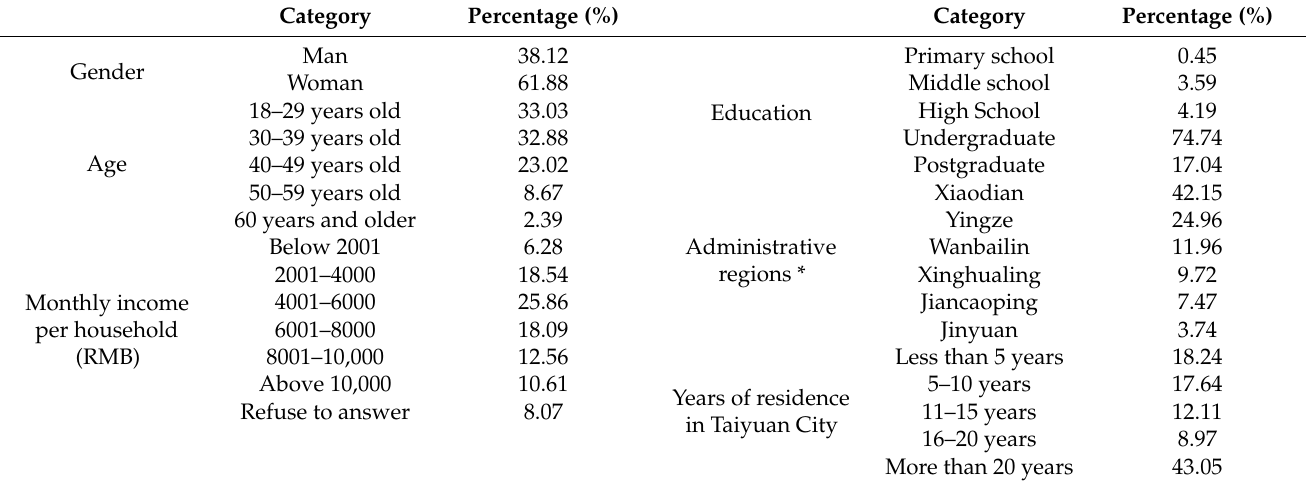
Table 3. Demographic profile of